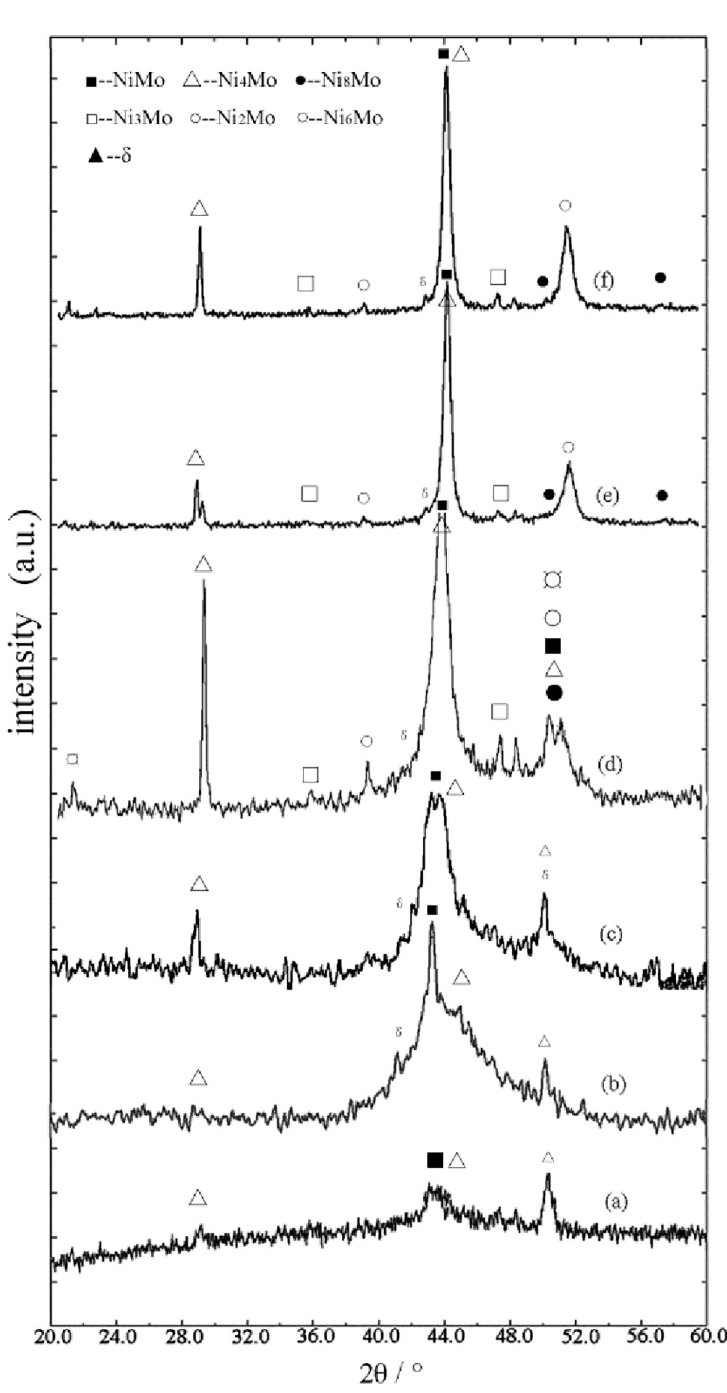
Fig 2. XRD curves of the deposited at different temperature (t = 30min). (a) as-deposited (b)250˚C (c)350˚C (d) 450˚C (e)550˚C